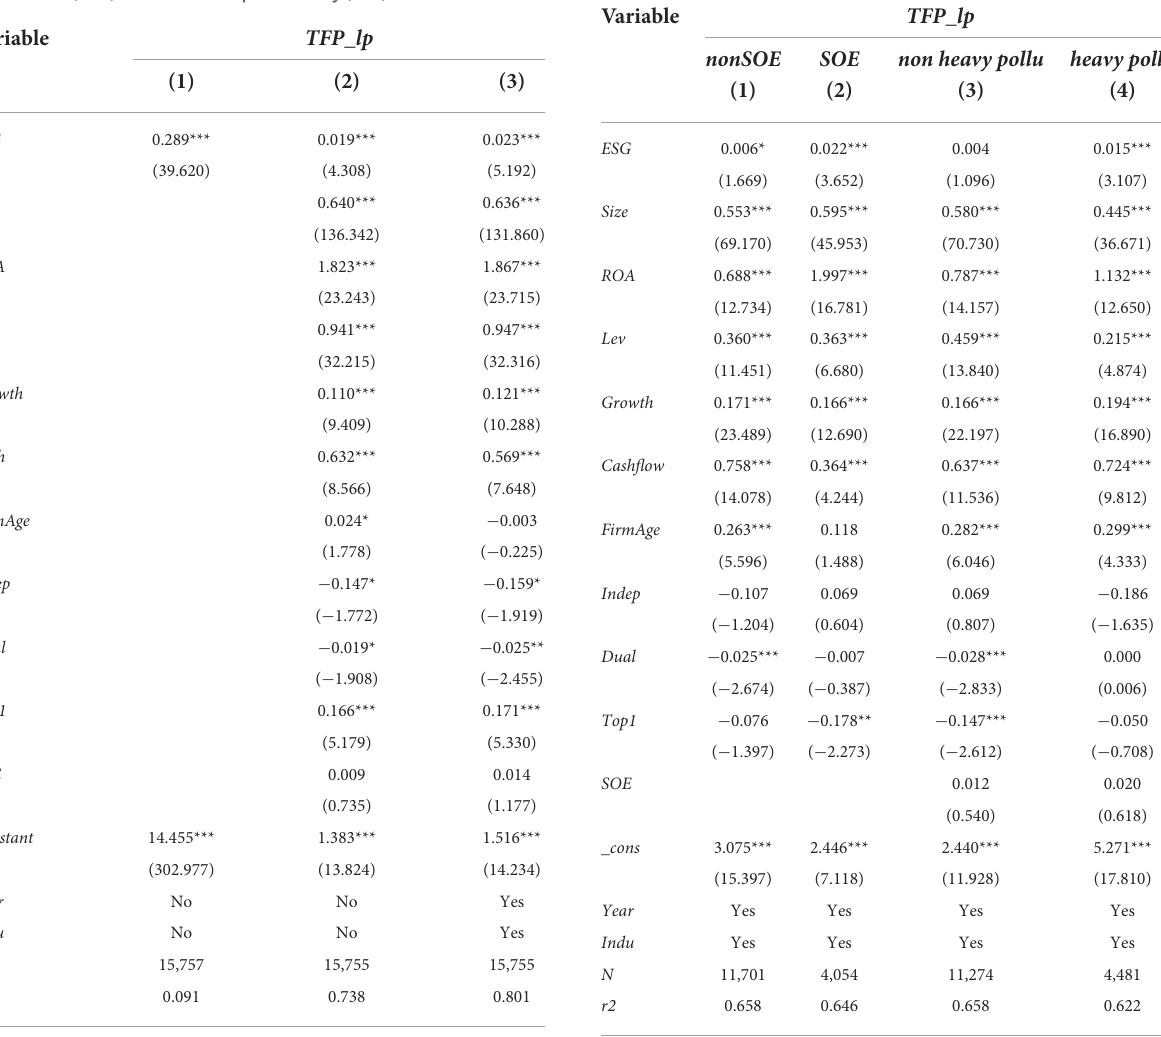
TABLE 3 Heterogeneity